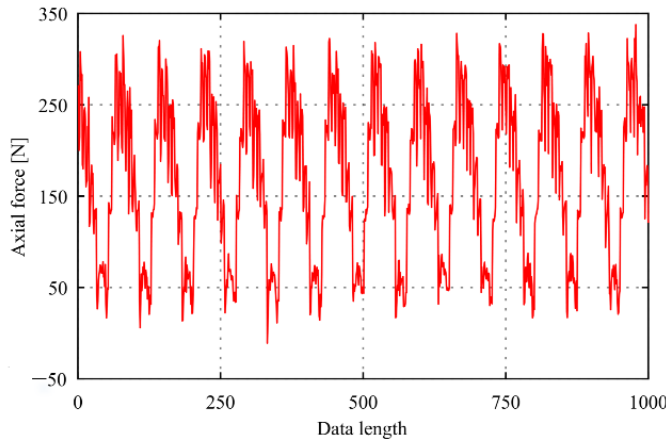
Figure 4. Waveform of original signal.